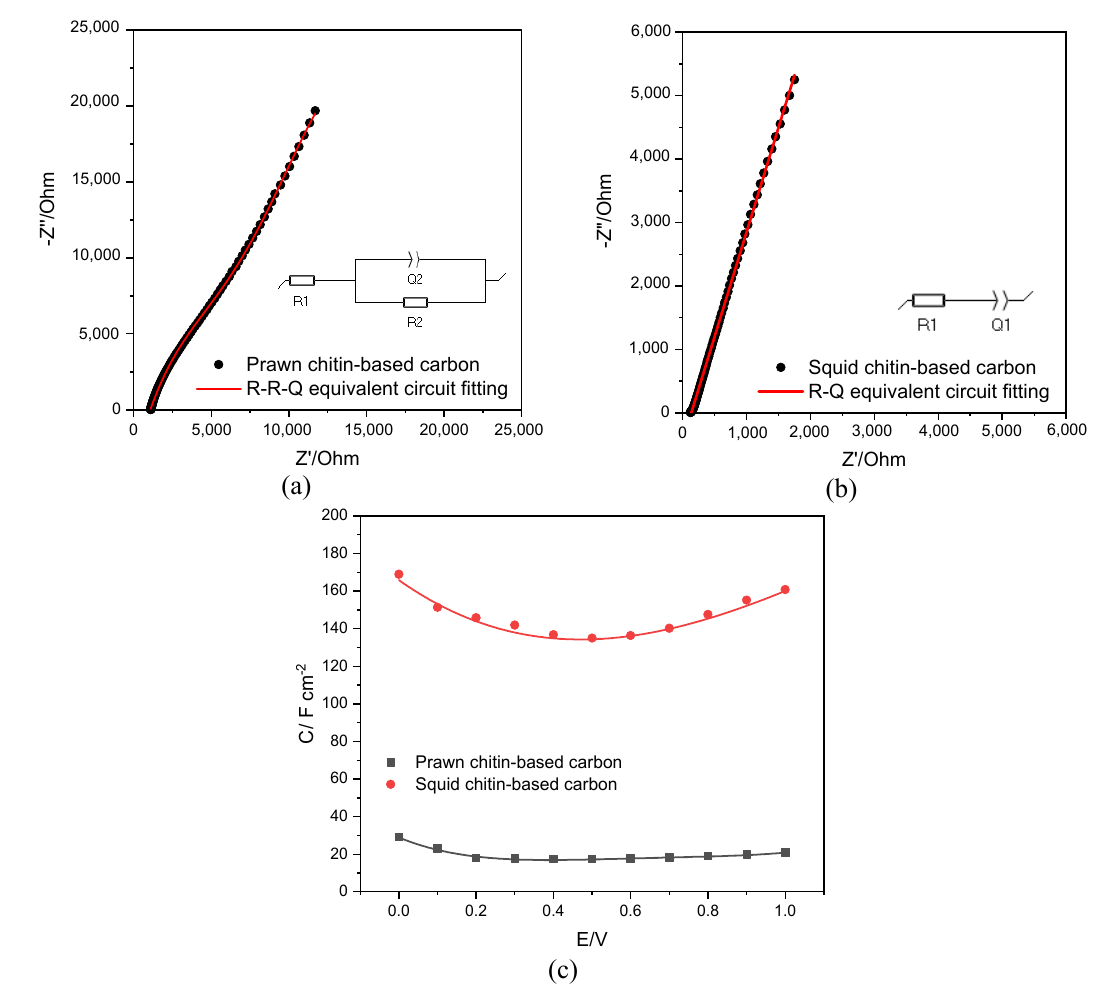
Figure 10. Nyquist plots for prawn ( a ) and squid ( b ) chitin-based carbons (+0.5 V vs. Ag). R(RQ) and RQ fitted to experimental data. ( c ) differential capacitance (F cm − 2 ) curves measured at chitin-prawn and chitin-squid/DES interface in the accessible potential window (0 V–1 V).